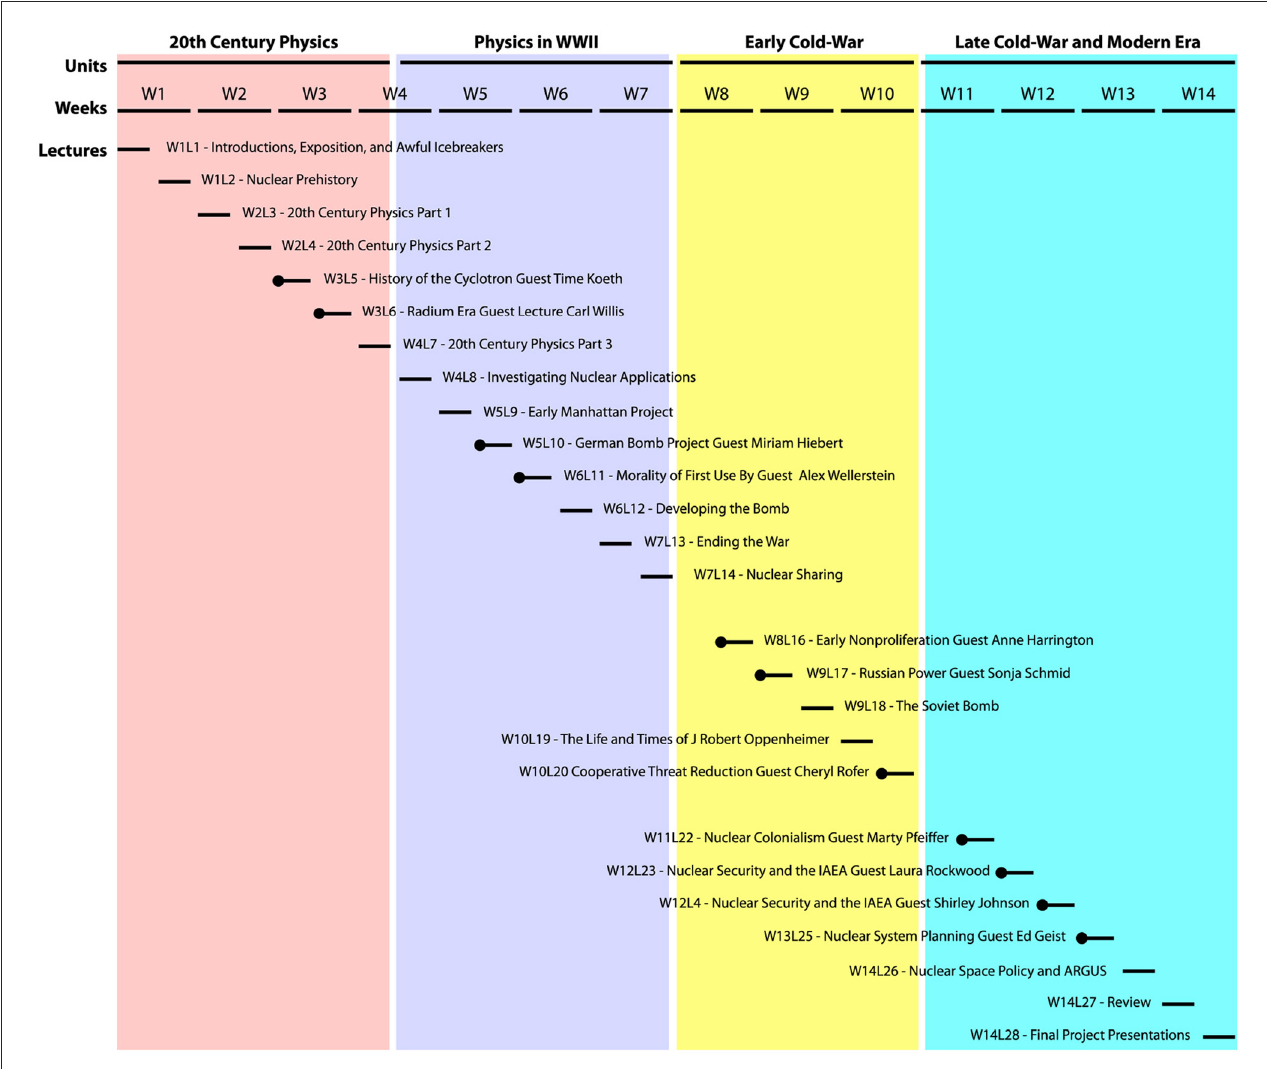
FIGURE1 Graphical syllabus for NE290 course as broken down hierarchically in terms of units, weeks, and lectures. Units are colored. Guest lectures are indicated by a (cid:13) marker. All lectures slides are provided as supporting